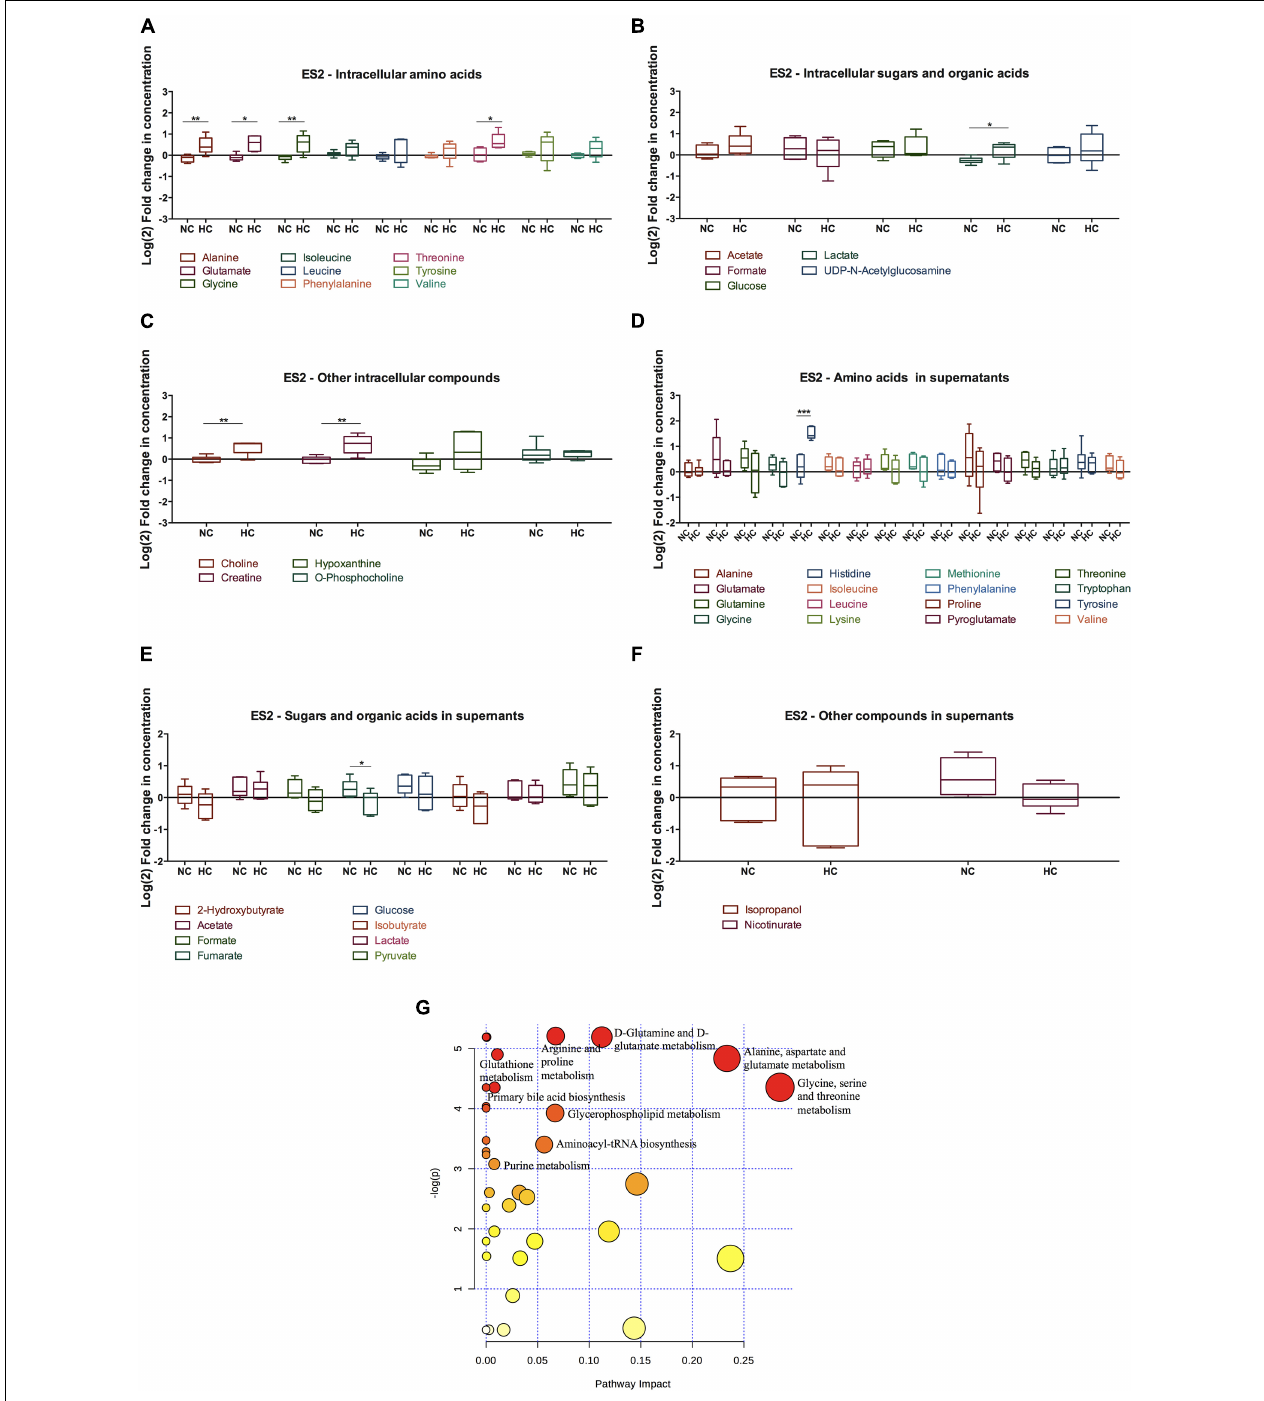
FIGURE 4 | Cysteine rescues ES2 cellular metabolism and impacts several metabolic pathways under hypoxia. (A–F) Metabolites levels for 48 h of experimental conditions for ES2 cells. (A) Intracellular amino acids; (B) intracellular sugars and organic acids; (C) other intracellular metabolites; (D) amino acids in supernatants; (E) sugars and organic acids in supernatants; (F) other metabolites in supernatants. Data were normalized to the respective control condition (the same environmental condition NC/N and HC/H). NC, normoxia with cysteine; HC, hypoxia with cysteine. Results are shown as median with 25th to 75th percentiles. * p < 0.05, ** p < 0.01, *** p < 0.001 (independent-samples t- test: NC, n = 6; HC, n = 5). (G) Metabolic pathway analysis for the effect of cysteine under normoxia and hypoxia in intracellular ES2 metabolites. All the matched pathways are displayed as circles. The color and size of each circle are based on p -value and pathway impact value, respectively. The most impacted pathways having statistical significance ( p < 0.05) are indicated. Source: https://www.metaboanalyst.ca/Metabo Analyst/faces/home.xhtml.